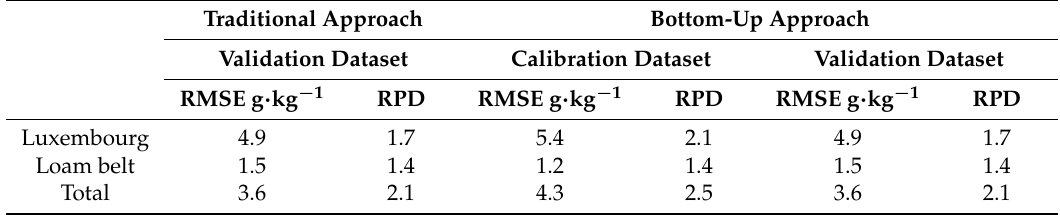
Table 3. Estimation accuracy in terms of root mean square error (RMSE) and ratio of the performance to deviation (RPD) obtained from the validation datasets using the traditional and bottom-up